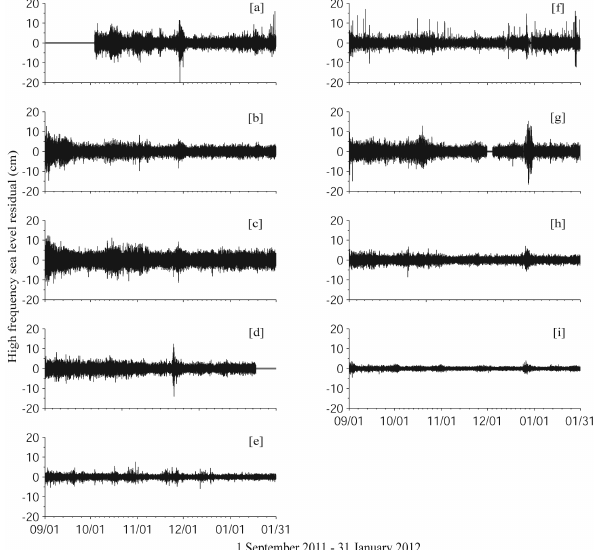
Figure 9. High-pass filtered sea-level residual (hf-SLR) using a 5th order Butterworth filter (time period ≤ 2h) at (a) Ratnagiri, (b) Verem, (c) Karwar, (d) Tuticorin, (e) Mandapam, (f) Gopalpur, (g) Gangavaram, (h) Kakinada and (i) Port Blair.